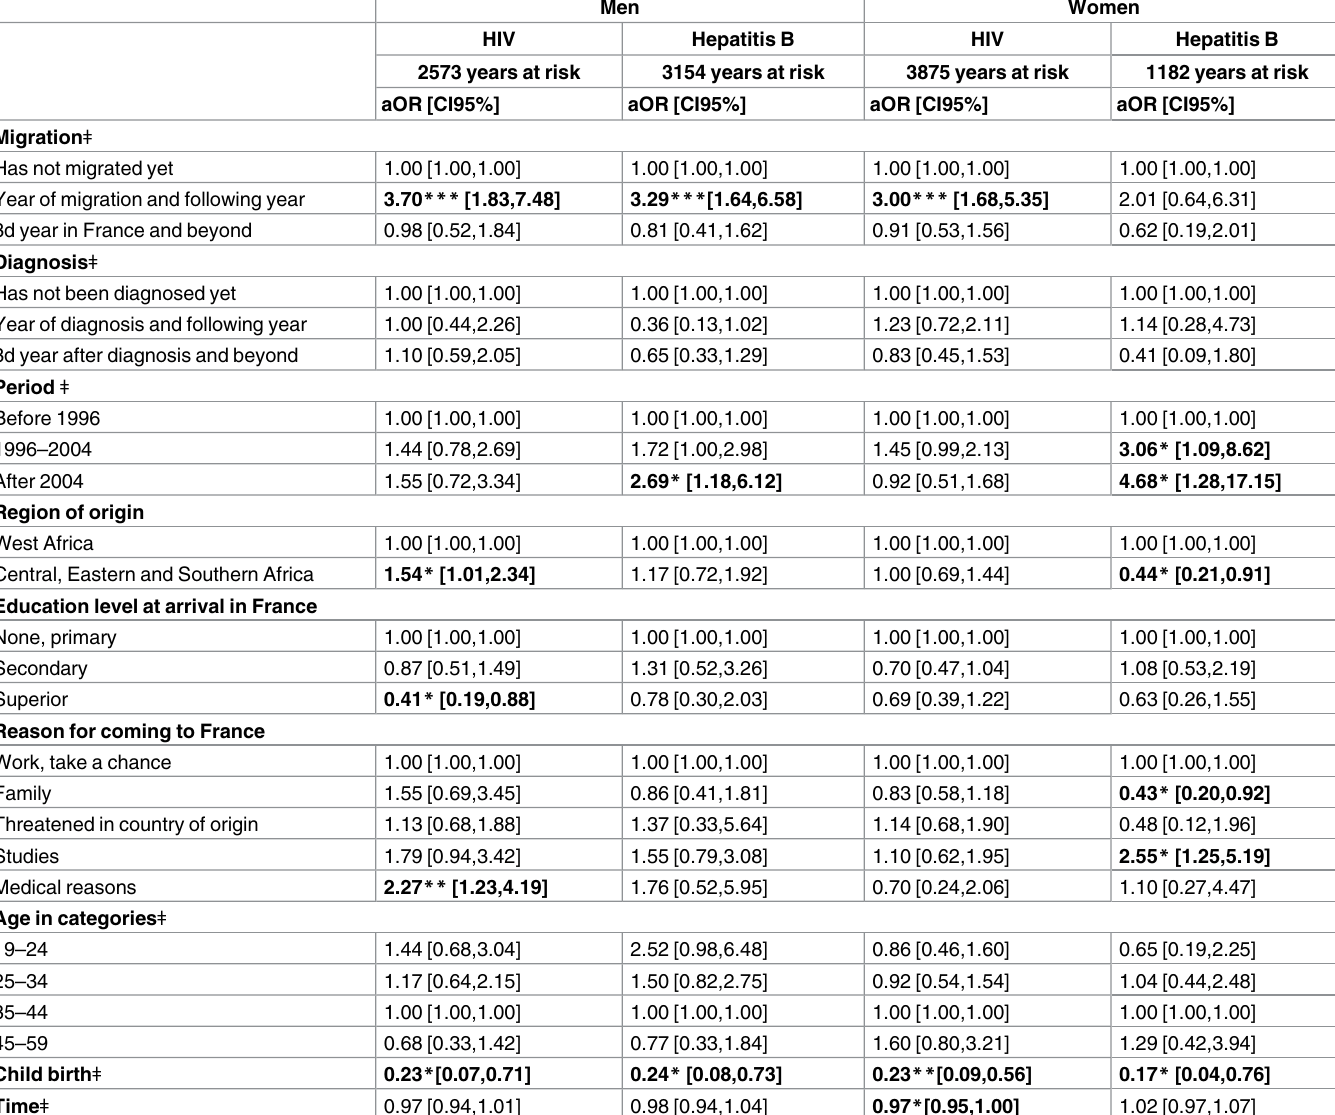
Table 3. Factors associated with conjugal break up year by year since 18 yearsof age until data